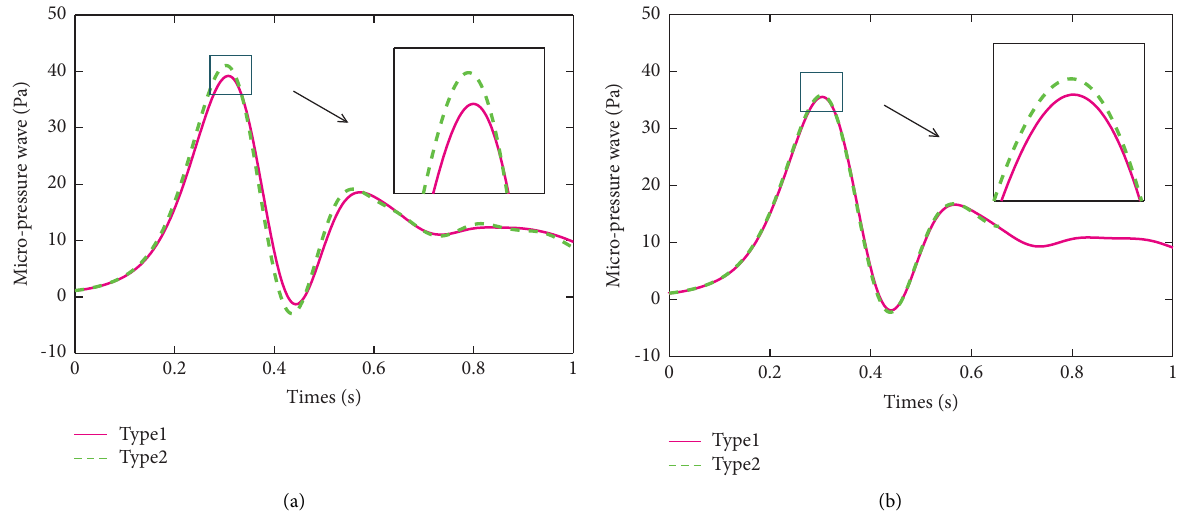
Figure 14: Comparison of the micropressure wave at M 3. (a) Linings at the tunnel entrance. (b) Linings at the tunnel